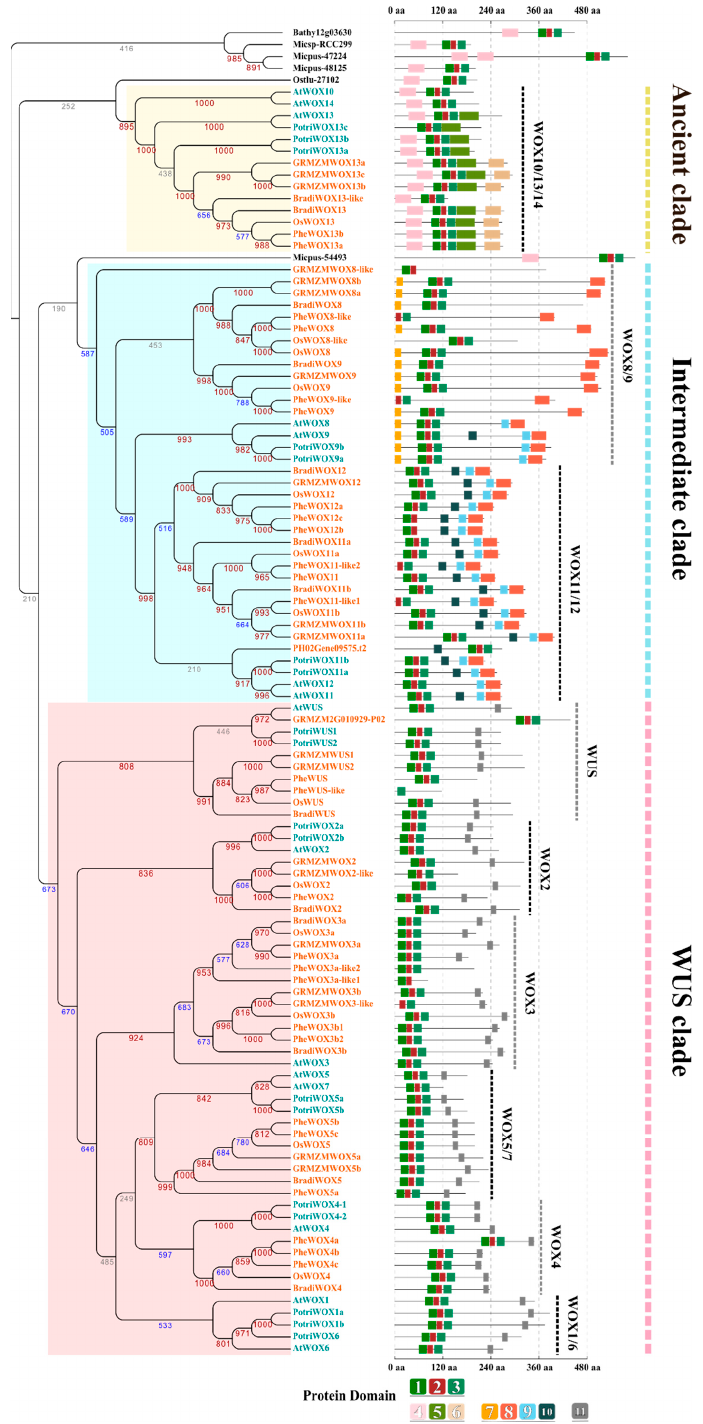
Figure 2. The phylogenetic tree of WOXs from dicots and monocots. The neighbor-joining tree was constructed using amino acid sequences of WOXs from Arabidopsis thaliana (At), Populus trichocarpa (Potri), Oryza sativa (Os), Zea mays (Zm), Brachypodium distachyon (Bradi), Micromonas pusilla (Micpu), Micromonas sp. (Micsp), Ostreococcus tauri, (Osta), and Bathycoccus prasinos (Bathy), with bootstrap assessment of 1000 replicates. Each clade was assigned a di ff erent colored background. Leaf colors of black, orange, and cyan stand for WOXs of chlorophytes, monocots, and dicots, respectively. The graphic symbols of the conserved motifs are colored and termed the same as in Figure